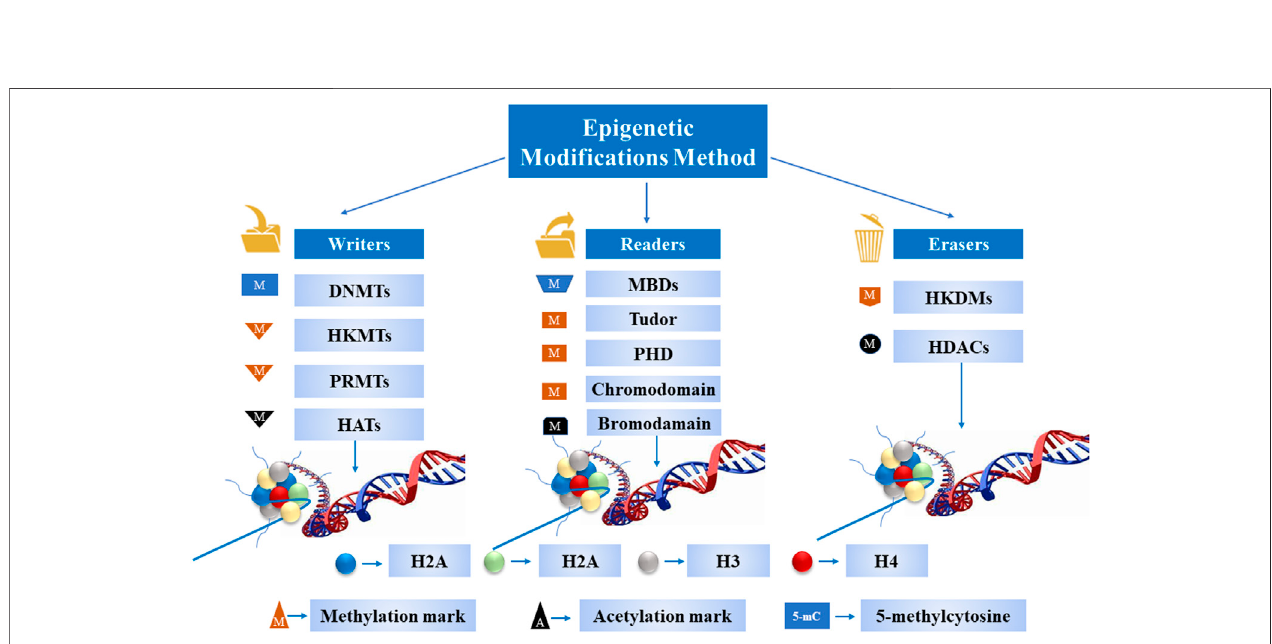
FIGURE2| Aschematicdiagramofepigenetictools.Theseenzymesandproteindomainscarryoutmostoftheepigeneticmodi fi cationsonDNAandhistonetails.